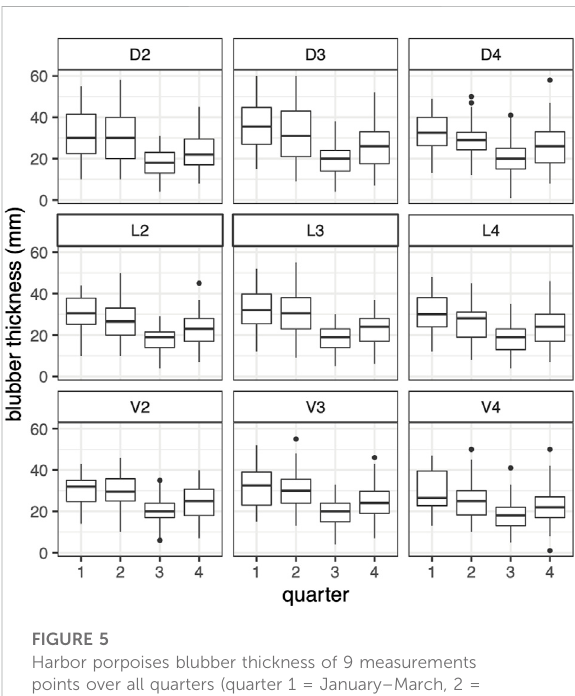
FIGURE 5 Harbor porpoises blubber thickness of 9 measurements points over all quarters (quarter 1 = January – March, 2 = April – June, 3 = July – September, 4 = October – December), shown for health status “ good ” ( n =